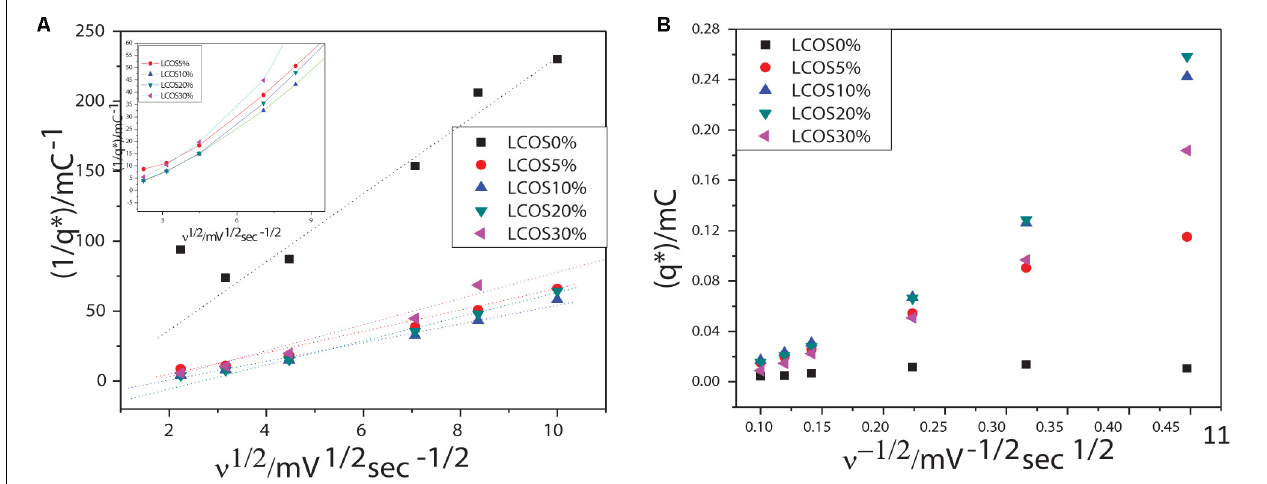
FIGURE 4 | Scan rate dependency of voltammetric charges: extrapolations of (A) the total charges ( q * total ) and (B) the most accessible charges ( q * outer ) of the LSCO0%, LSCO5%, LSCO10%, LSCO20%, and LSCO30% samples.